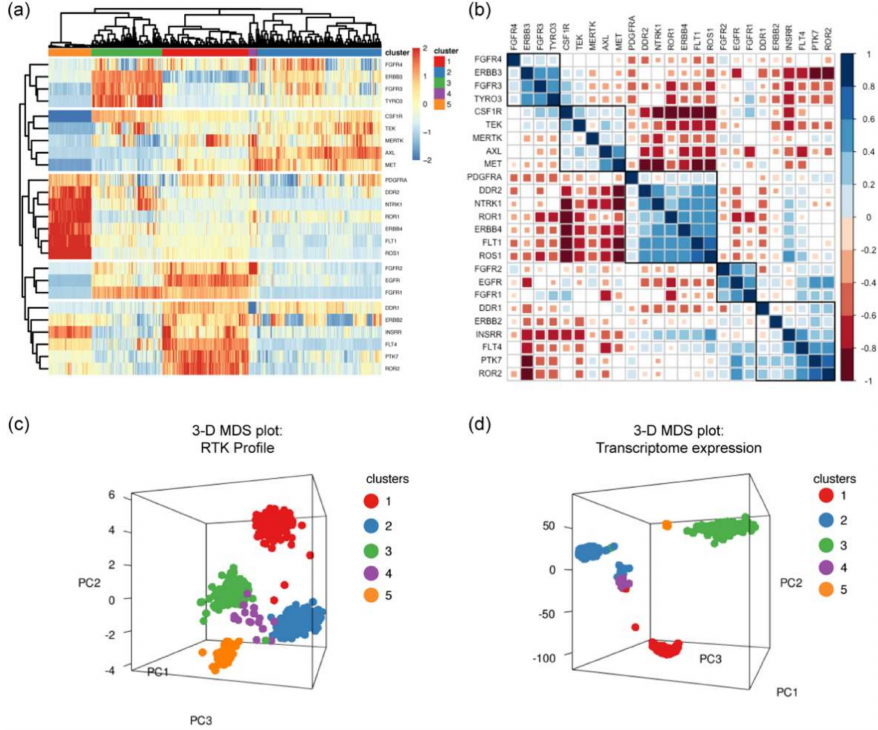
Figure 3. Molecular subtypes with distinct RTK profile can be identified using RTK25. ( a ) Hierarchical clustering was performed on the CCA tissues ( n = 704) based on the gene expression of selected RTKs (RTK25). The heatmap indicates the expression values (red indicates high expression and blue indicates low expression) of RTK25 in each cluster (red = 1, blue = 2, green = 3, purple = 4, and orange = 5). ( b ) Correlation matrix shows significant ( p < 0.05) Pearson correlation coefficients. Color indicates correlation (blue, positive correlation ( r = 0 to 1); red, negative correlation ( r = − 1 to 0)). Area of the square indicates the value of the corresponding Pearson’s correlation coefficients. Multi-dimensional scaling (MDS) plot of 704 CCA samples based on the expression of ( c ) RTK genes ( n = 25) and ( d ) all the common genes from the merged expression data ( n = 13454). PC1: first MDS component ( x -axis); PC2: second MDS component ( y -axis); PC3: third MDS component ( z